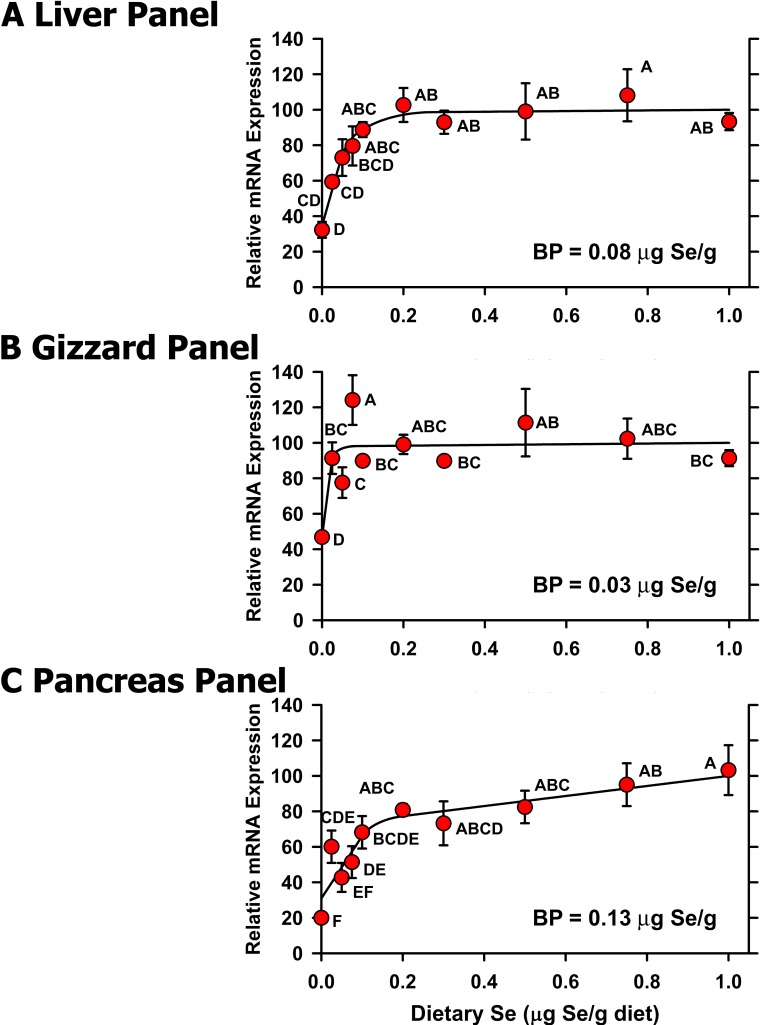
Effect of dietary Se on transcript panel values in chick liver (A), gizzard (B), and pancreas (C). Within a tissue, the individual relative transcript levels for each significantly-regulated selenoprotein were averaged to calculate panel values, which were then subjected to the Se response curve analysis as described in the text. Resulting mean±SEM are plotted, and means without a common letter are significantly different (P<0.05). Overall level of significance, as determined by ANOVA, is given in Table 3. Se response curve breakpoints (BP) are indicated in each panel, calculated as described in the text.